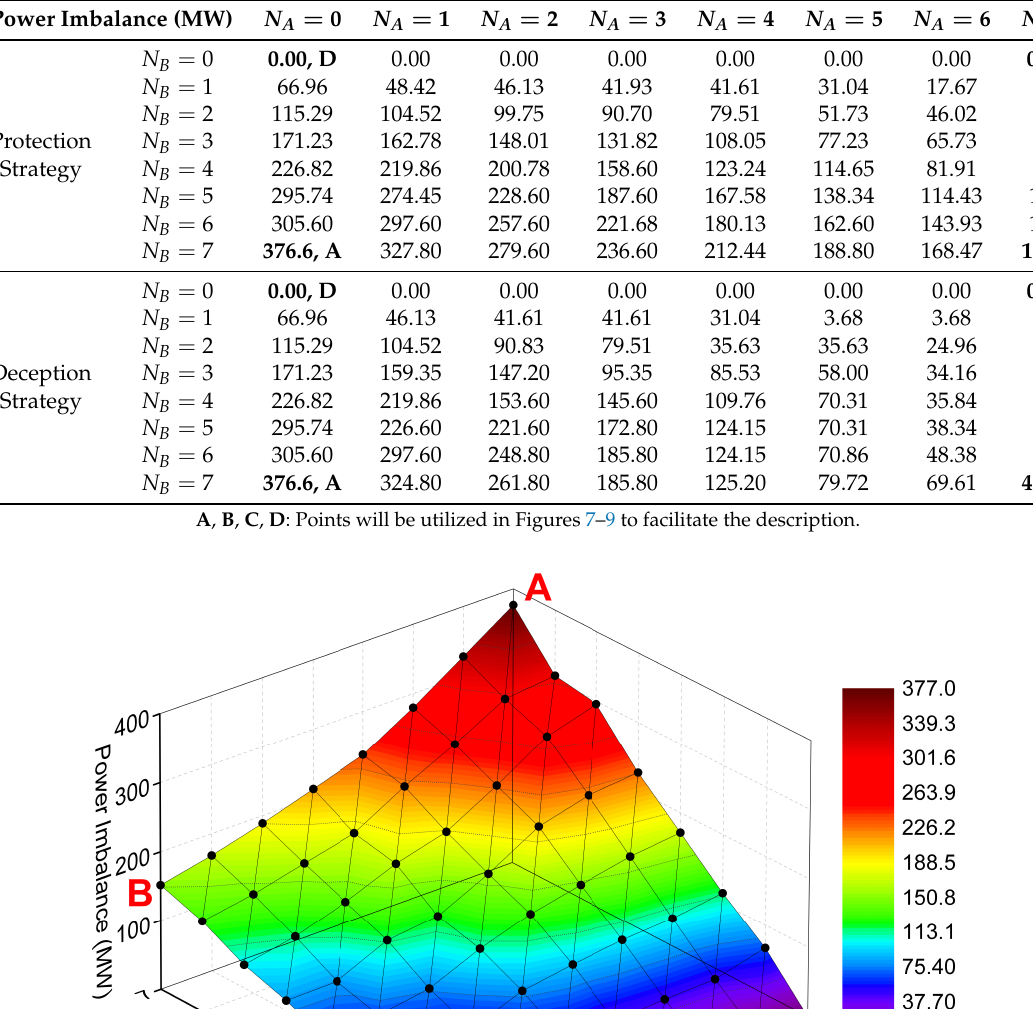
Table 5. Power imbalance with both strategies under different defense and attack budgets.